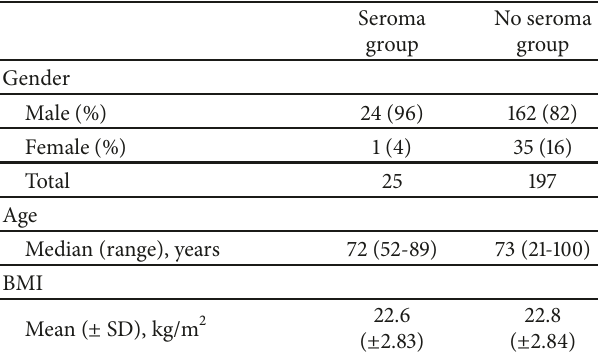
Table 2: Patients’